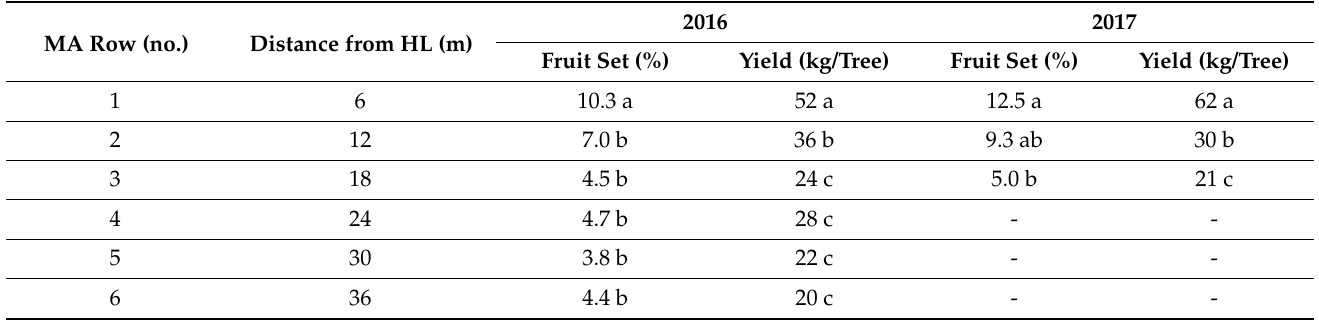
Table 2. The effect of the pollinizer HL on fruit set and yield of MA trees at different distances, Almagor 2016–2017.